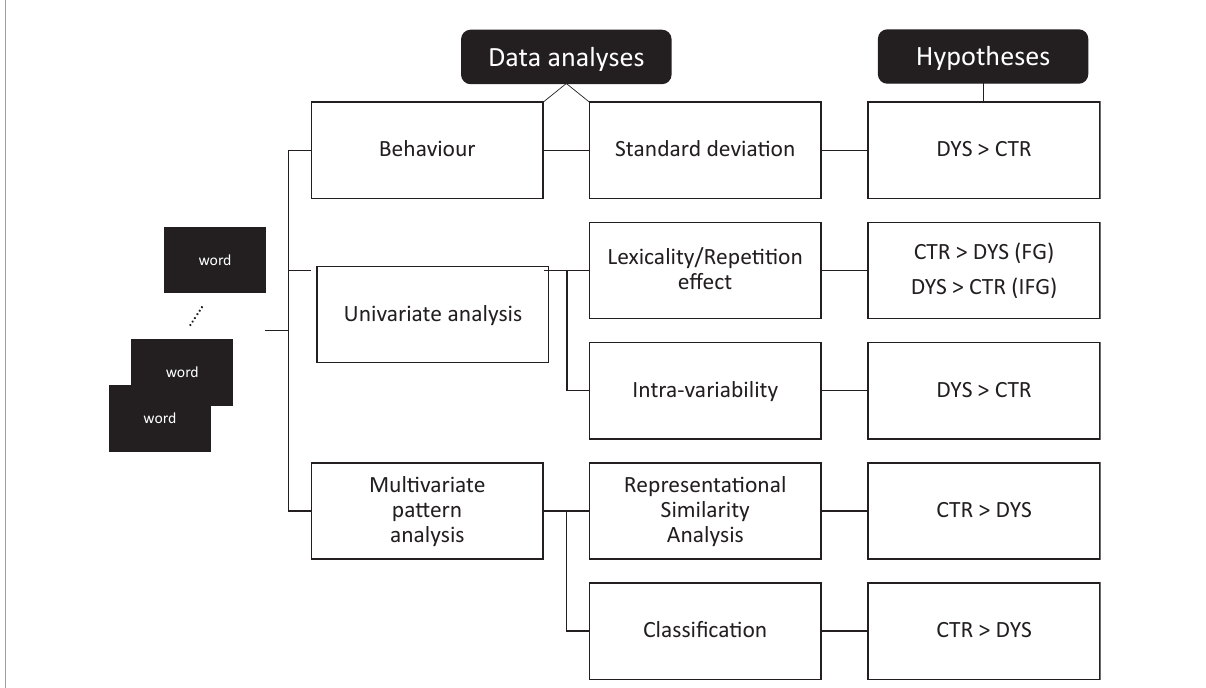
FIGURE1 Testing the neural noise theory. Main predictions of the neural noise theory for the various analyses. DYS: dyslexic readers, CTR: typical readers, FG: fusiform gyrus, IFG: inferior frontal gyrus.